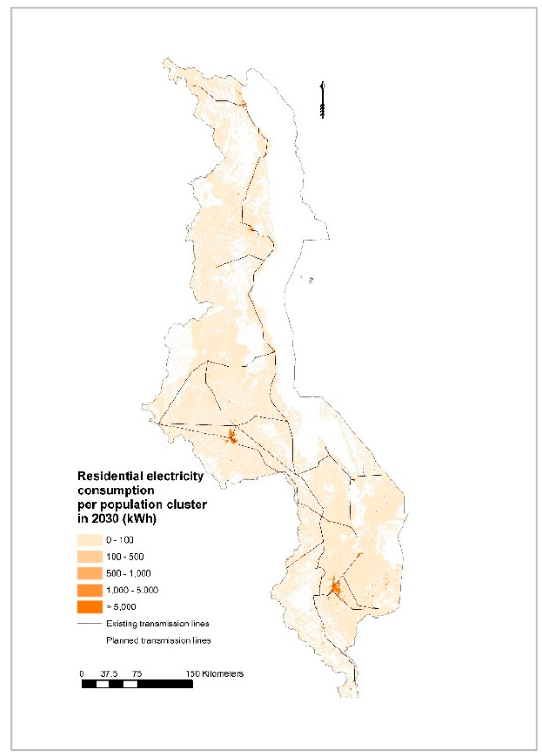
Figure 5. Distribution of the expected residential electricity demand per population cluster based on specified access targets (Tier 4 for urban and Tier 1 for rural clusters) in Malawi.